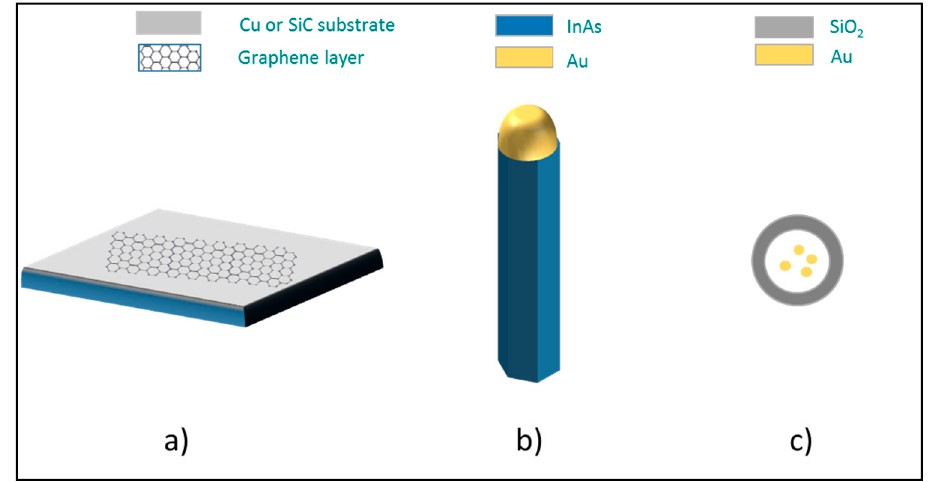
Figure 1. The three nano-objects and their agglomerates and aggregates (NOAA): two-dimensional (2D) graphene (G) ( a ), one-dimensional (1D) InAs nanowires (NW) ( b ) and zero-dimensional (0D) SiO 2 core shell nanoparticles with Au nanostructure (NP) ( c ).